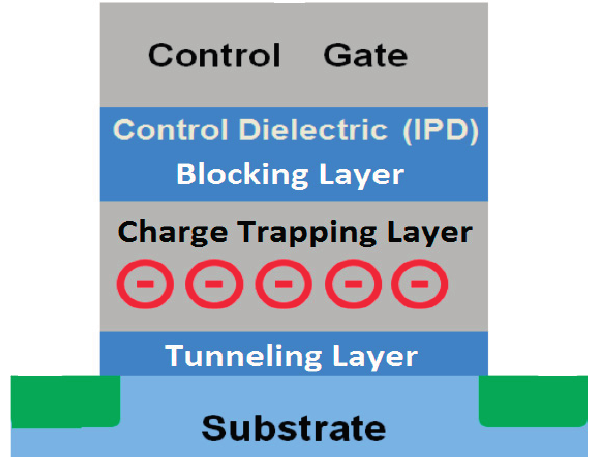
Figure 1. Cross-section schematic of a charge trapping memory transistor.